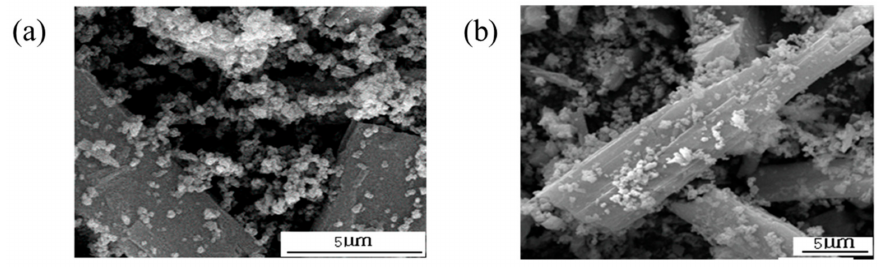
Figure 4. The SEM images of wollastonite and TiO 2 mixture particles. ( a ) Dry mixtures; ( b ) Wet